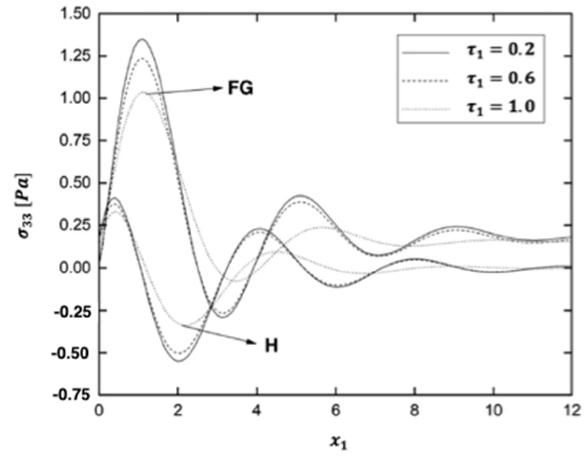
Figure 19. Variation of the thermal stress wave σ 33 along x 1 − axis in the functionally graded (FG) and homogeneous (H) anisotropic fiber-reinforced plates under different values of time characteristic of the laser pulse.